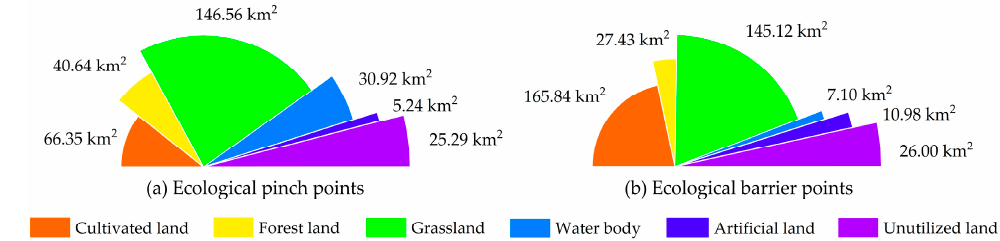
Figure 9. Land used areas of pinch points and barrier points in the Loess Plateau.